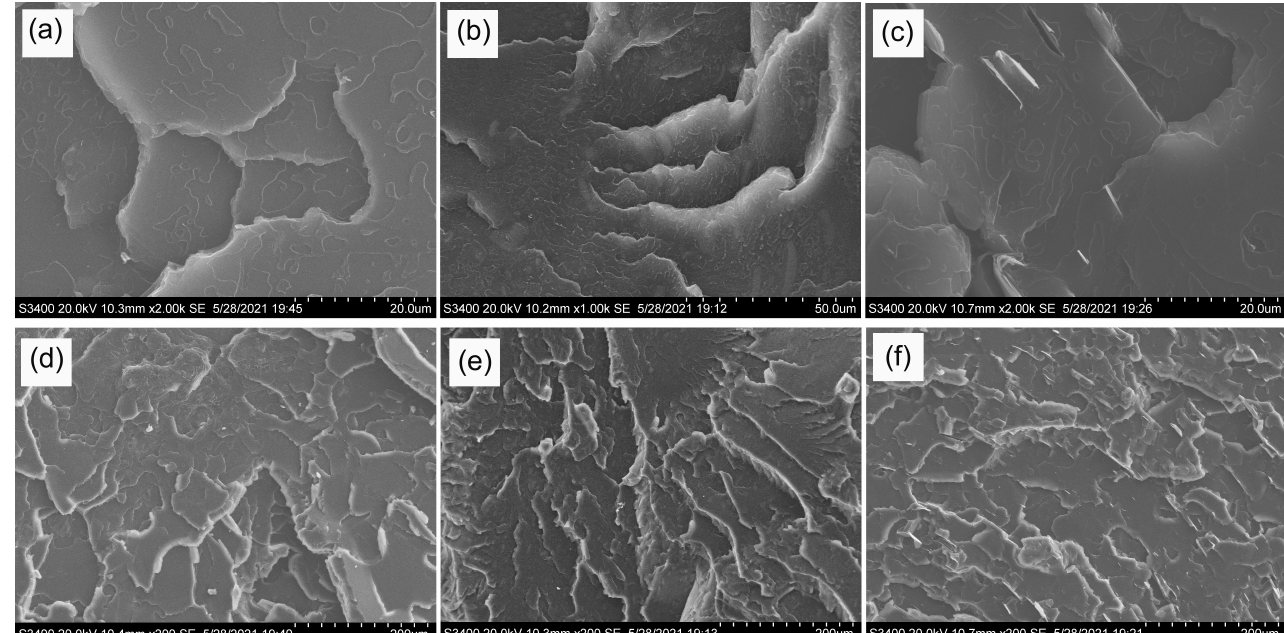
Figure 1. Cryo-SEM images of composite samples filled with 5 wt% of carbon allotropes: fullerenes